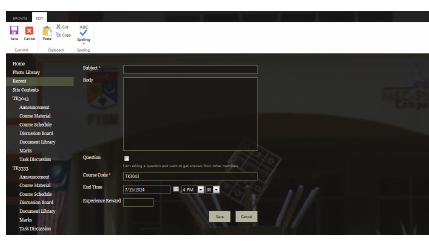
Figure 3: Assignment uploading